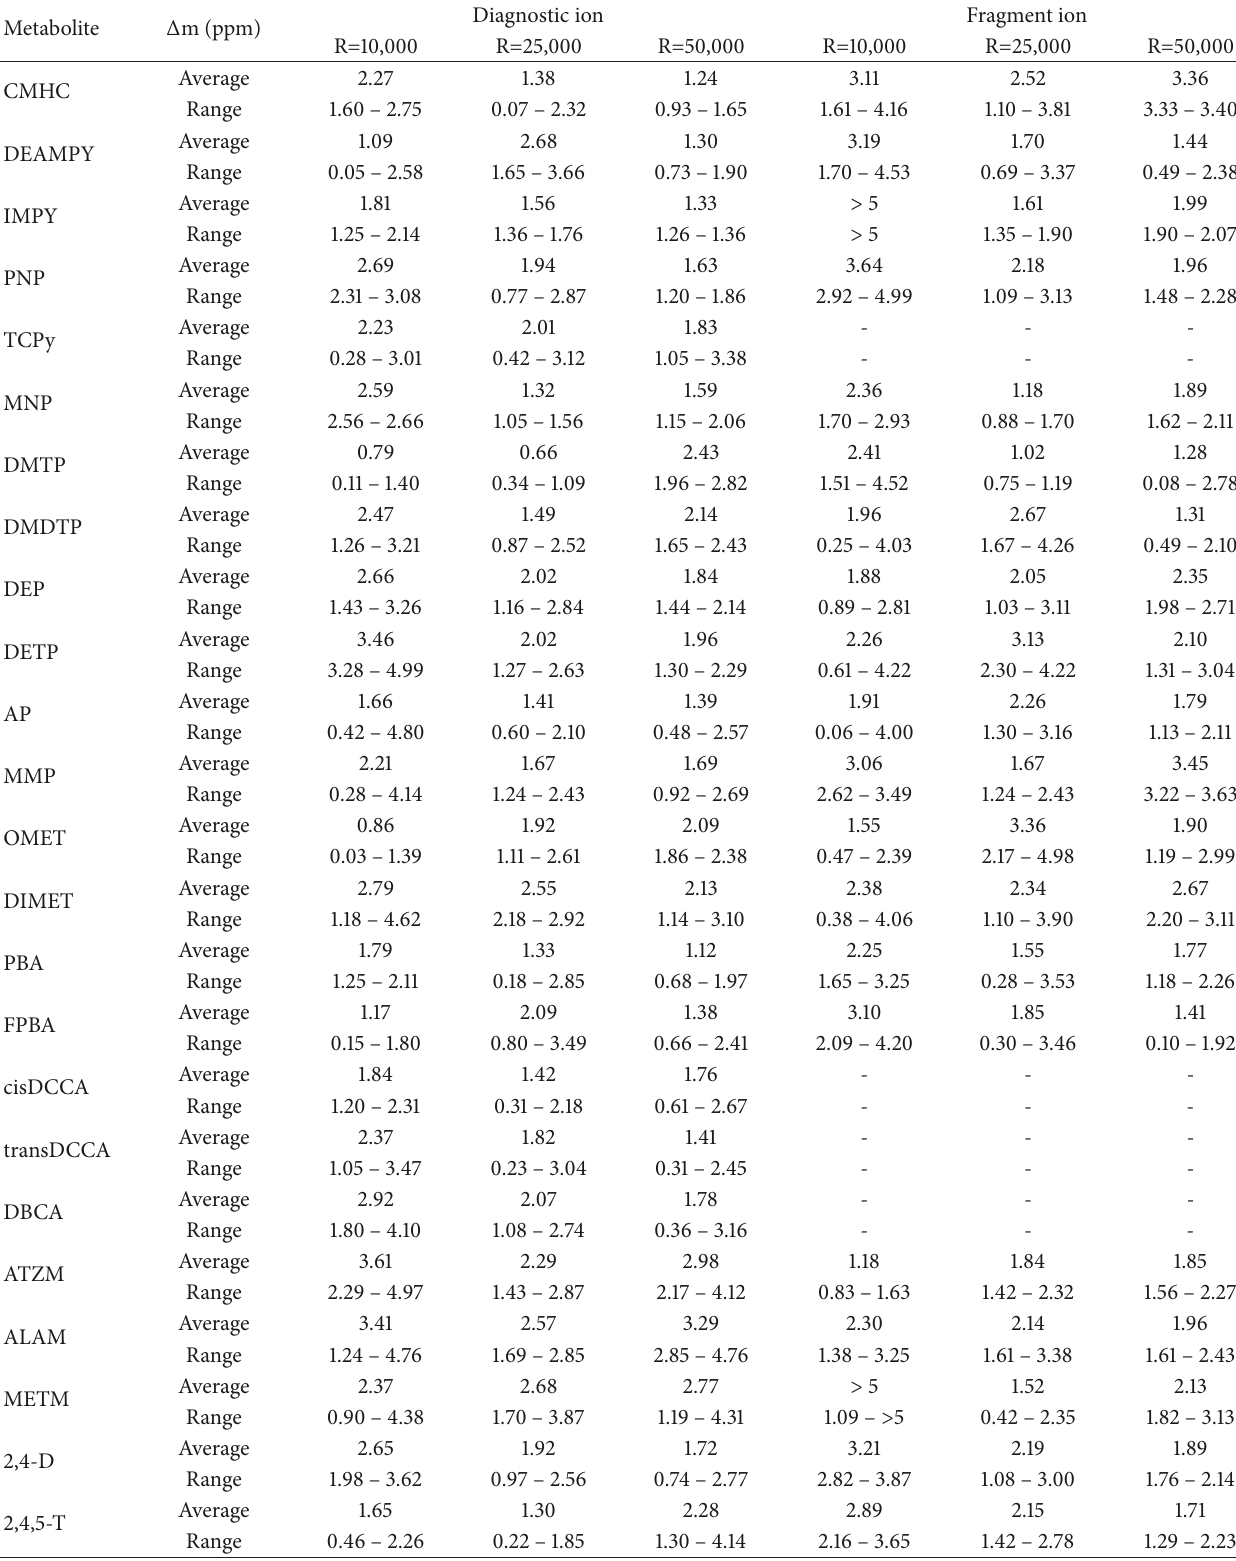
Table 3: Average and range of mass accuracies ( (cid:2) m) (ppm) obtained at 3 different Resolving Powers (R) for pesticide metabolites diagnostic and fragment ions